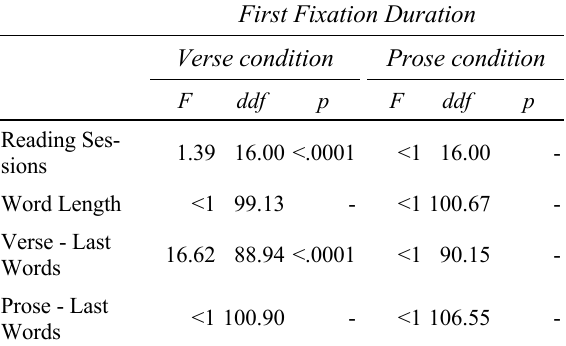
Table 2. Mixed model parameters for the separate analysis (verse vs. prose conditions) for first fixation duration reflecting pro- cesses of visual word recognition and orthographic/lexical access (lexical level).